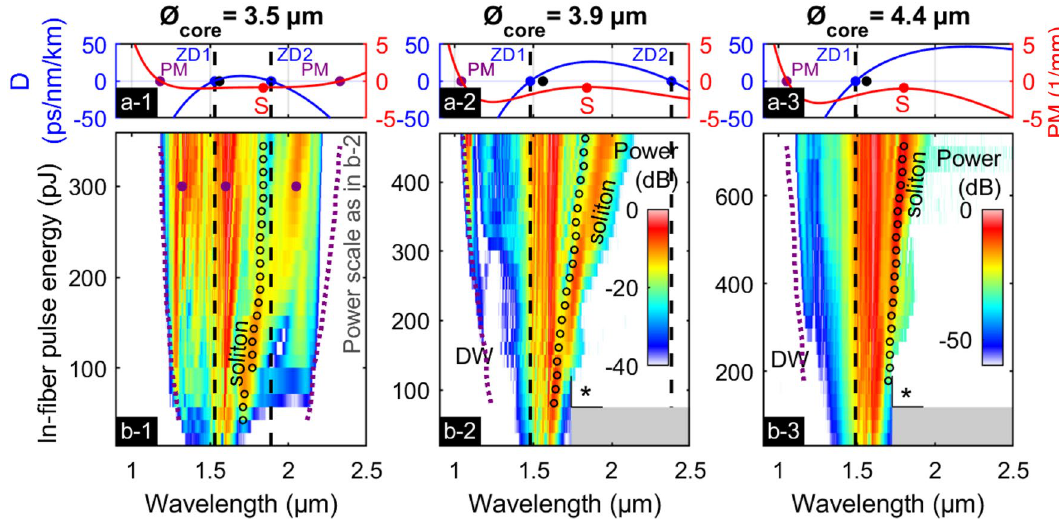
Figure 4. Supercontinuum generation in the TE 01 -mode in three CS 2 -core fibers having different core diameters (Ø core = 3.5 µm (column 1), Ø core = 3.9 µm (column 2), Ø core = 4.4 µm (column 3)). The top row ( a ) shows the group velocity dispersion parameter D (blue, left axis) and phase-mismatch (PM) in 1/mm (red, right axis), while the energy-spectral evolutions are shown in the bottom row ( b) . The energy-dependent intra-modal phase-matching wavelengths (purple dotted lines) are calculated for the respective soliton wavelengths (black circles). The asterisk (*) marks the start of the spectra with reduced dynamic range, detected with a less sensitive spectrometer. No experimental data is available in the gray shaded regions. The big purple dots in ( b-1 ) mark exemplarily the wavelengths matched by degenerated four-wave mixing between a pump at 1.6 µm in the AD regime and two wavelengths in the ND regime. Ø core